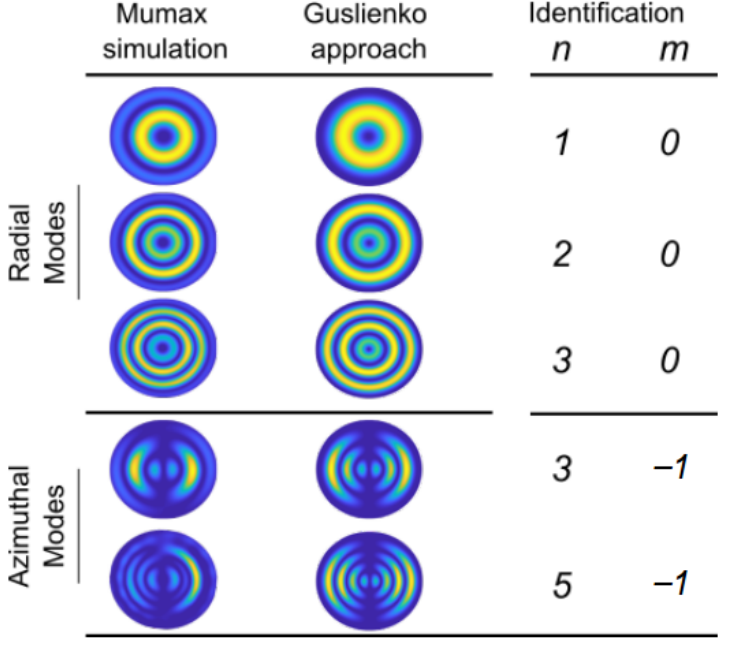
Figure 9. Identification of profile radial and azimuthal modes using the approach of Gareeva et